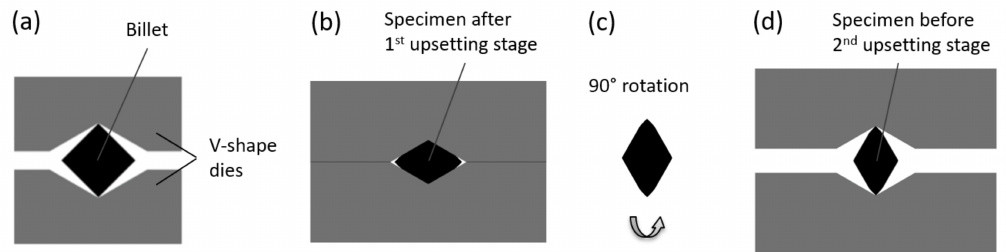
Figure 2. Schematic diagram of the upsetting by V-shape dies: ( a ) billet between the dies ( b ) first stage of the process ( c ) rotation of the specimen ( d ) second stage of the